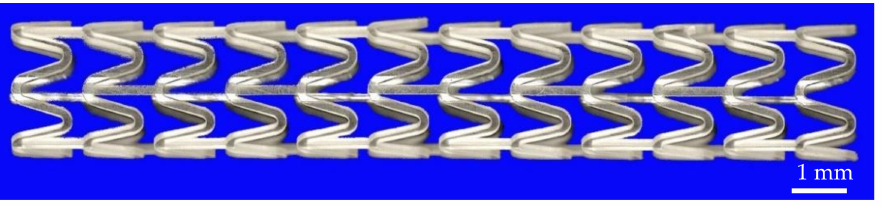
Figure 19. The engraved vascular